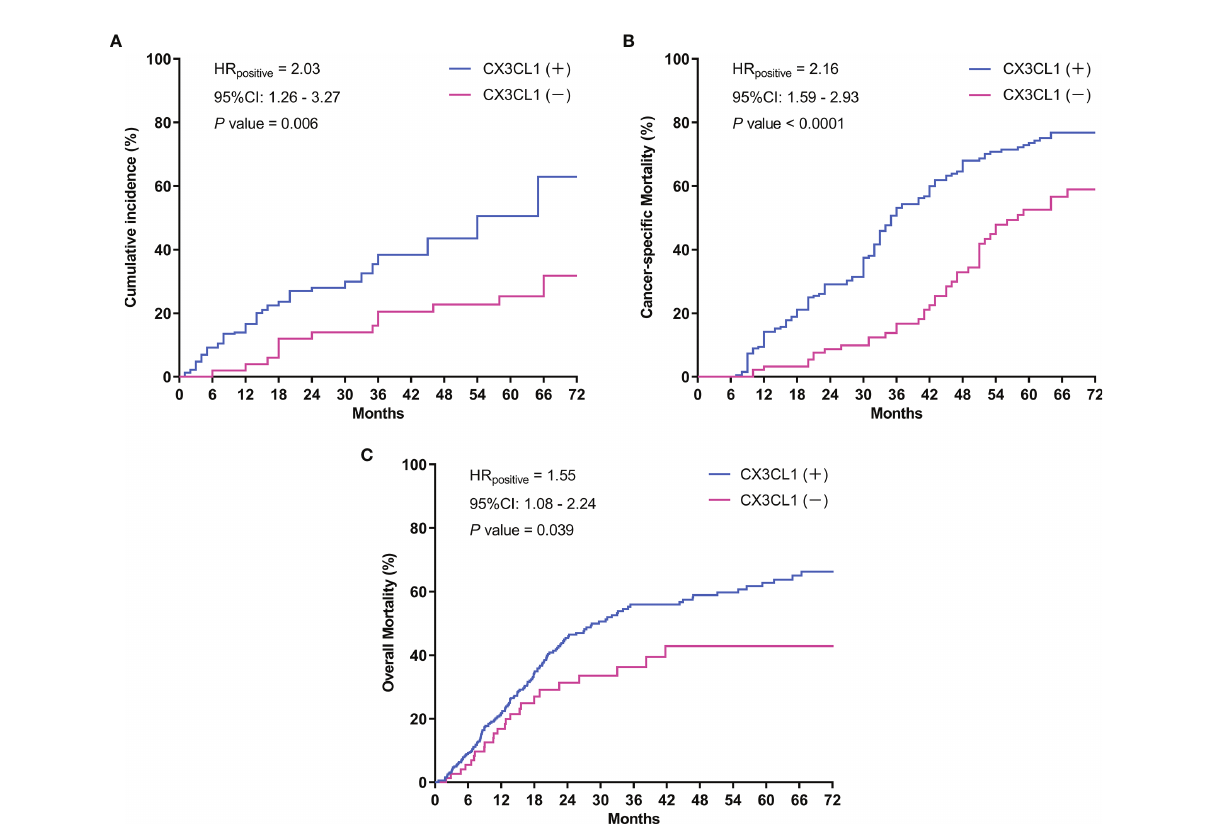
FIGURE 1 | Survival curves. (A) Cumulative tumor recurrence rate: the blue line represents the cumulative recurrence rate of 277 patients with bladder cancer with positive CX3CL1 expression; the red line represents the CX3CL1 expression-negative group. (B) Cancer-speci fi c survival: the blue line represents the cancer-speci fi c survival of the bladder cancer CX3CL1-positive group; the red line represents the CX3CL1 expression-negative group. (C) Overall mortality in the TCGA database: the blue line represents the overall mortality associated with 406 bladder cancer samples obtained from the TCGA database with positive CX3CL1 expression; the red line represents the CX3CL1 expression-negative group. HR, hazard ratio; 95%CI, 95% con fi dence